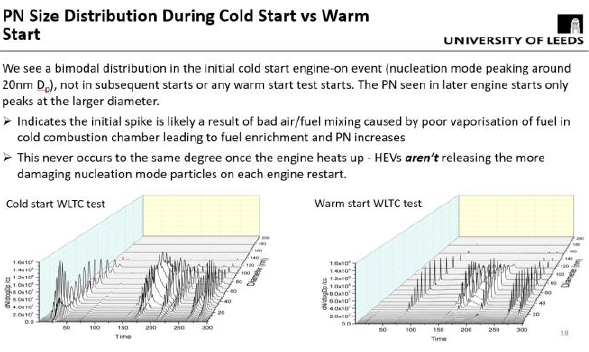
Fig. 14. Time-resolved PN size distribution profile for a hybrid vehicle running over the WLTP from cold and warm start conditions [49] Maciej Jaskiernik (FEV,